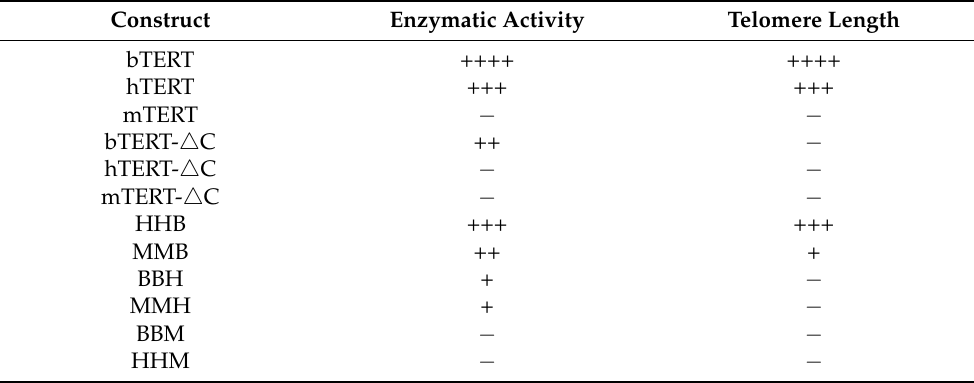
Table 1. Summary of activities of TERT mutants. Enzymatic activity was determined by TRAP. Telomere length was determined by quantitative real-time PCR. +, telomere maintenance; − , telomere